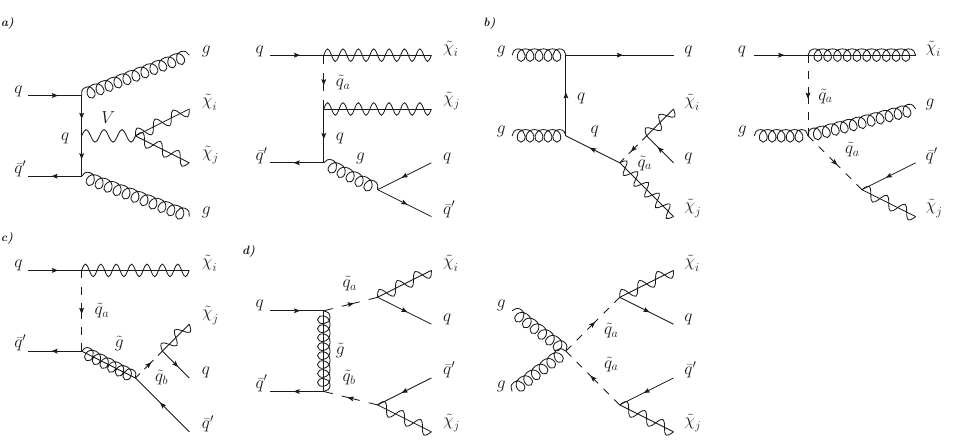
Figure 2 . Representative (a) non-resonant, (b) squark singly-resonant, (c) gluino singly-resonant, and (d) squark doubly resonant real-emission diagrams for the production of a pair of weakinos with a